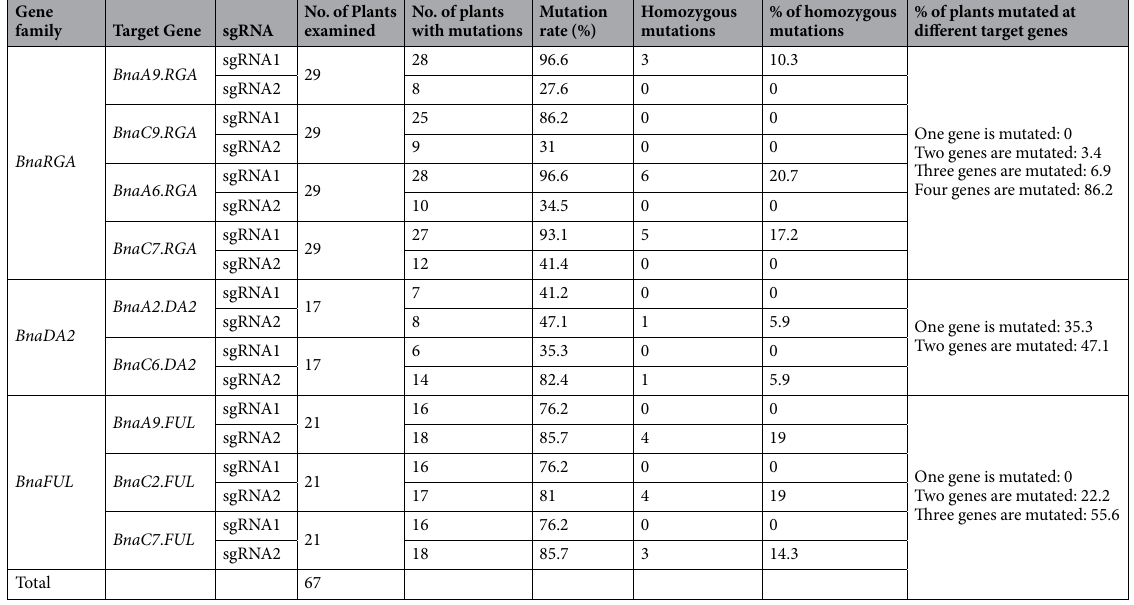
Gene family Target Gene